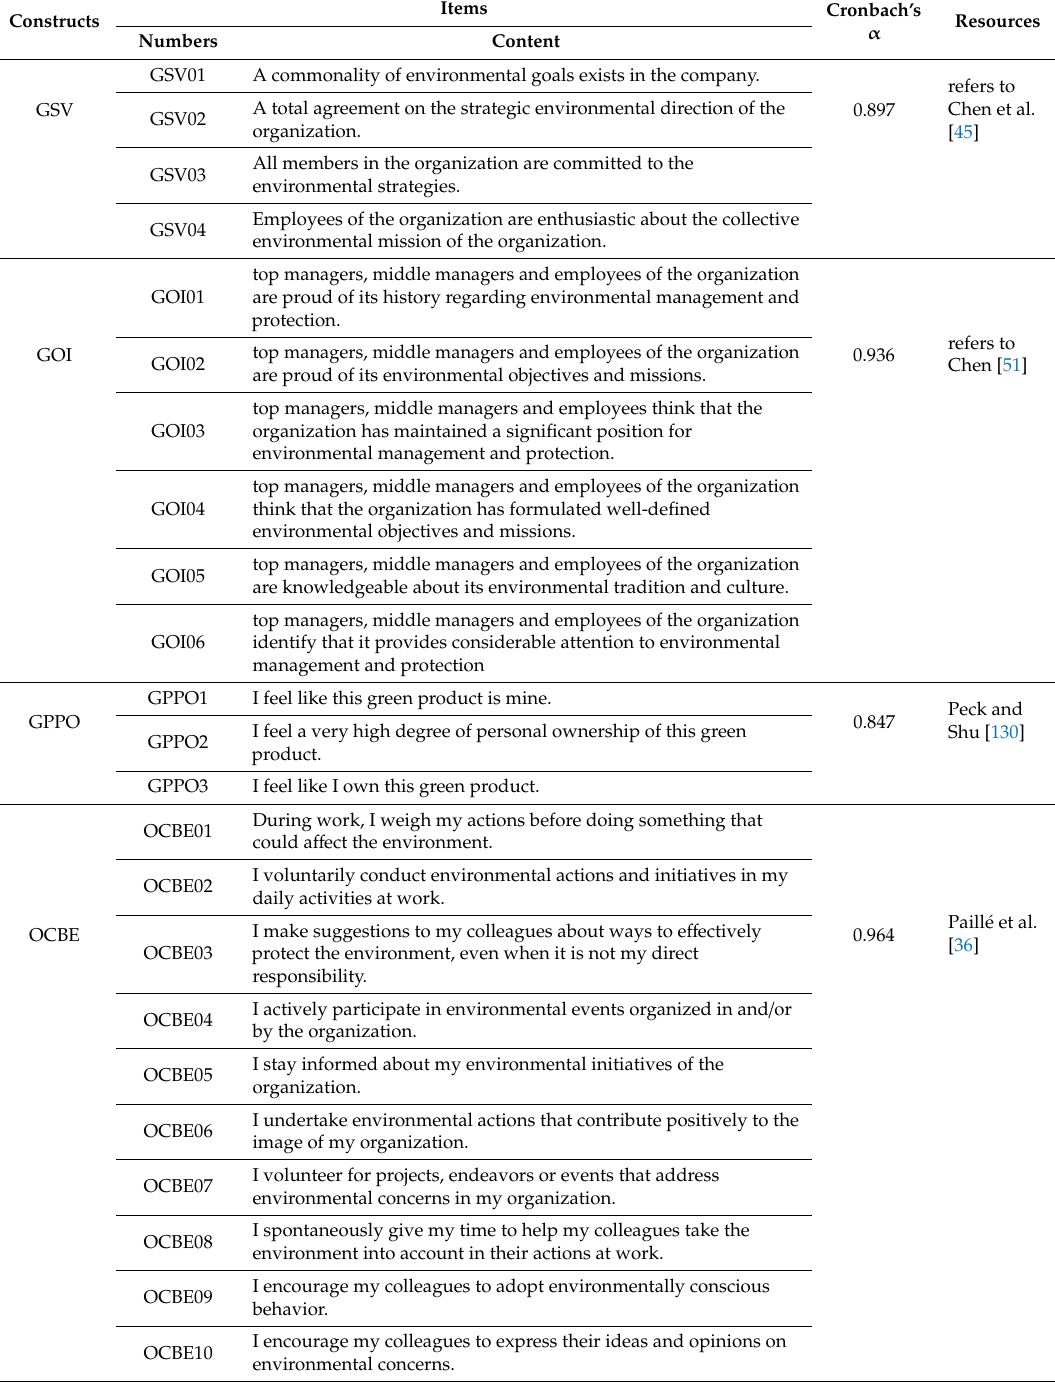
Table A1. Survey items for the